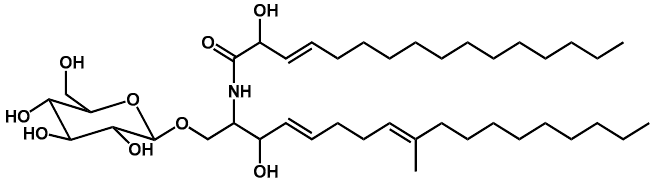
Figure 2. Structure of compound LAMA-1.